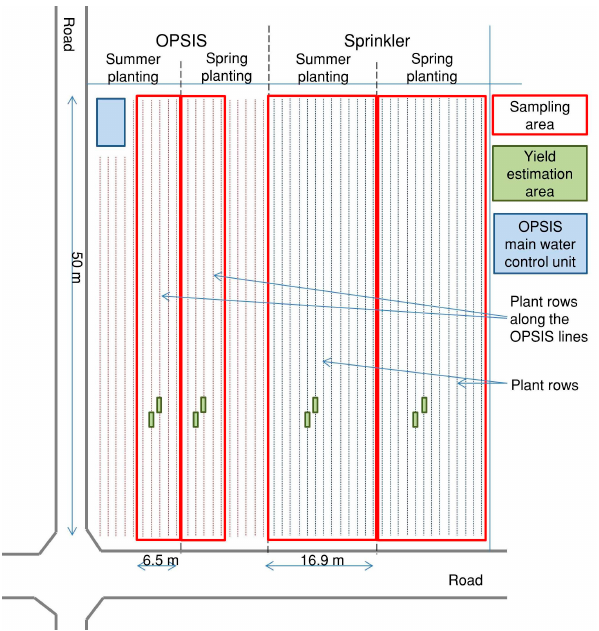
Figure 1. Field layout of experimental field (Teruya, Itoman) used to compare performance of optimized subsurface irrigation system (OPSIS) and conventional sprinkler irrigation in sugarcane cultivation.